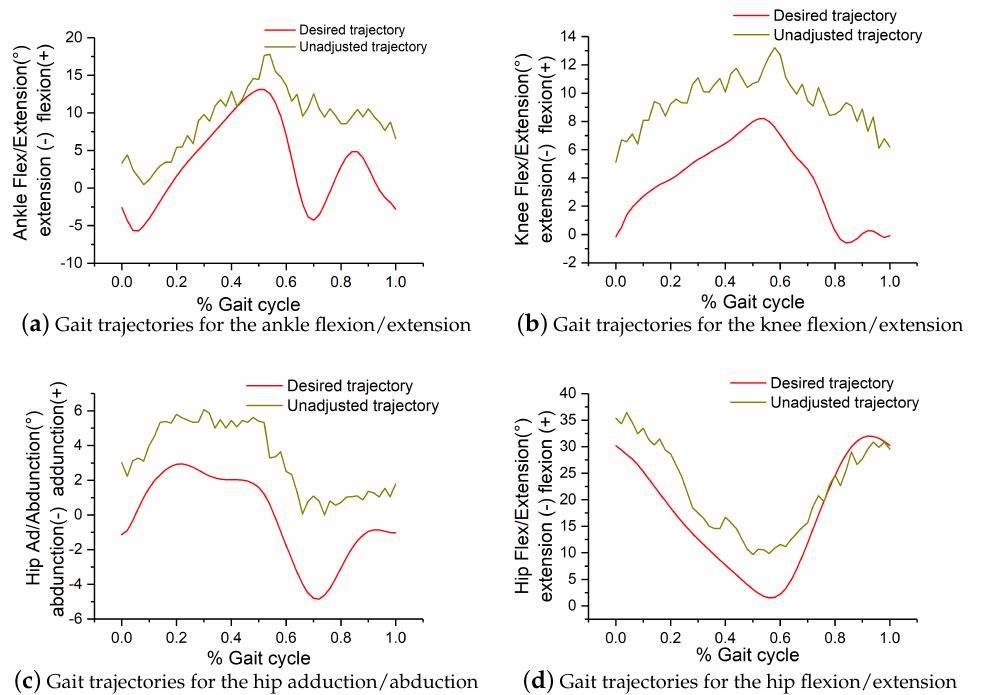
Figure 9. The simulated kinematics compared to the experimental data in